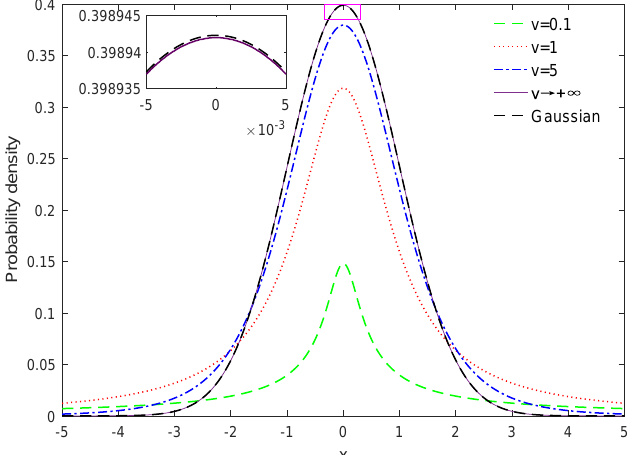
Figure 1. Illustration of Student’s- t distribution with various degrees of